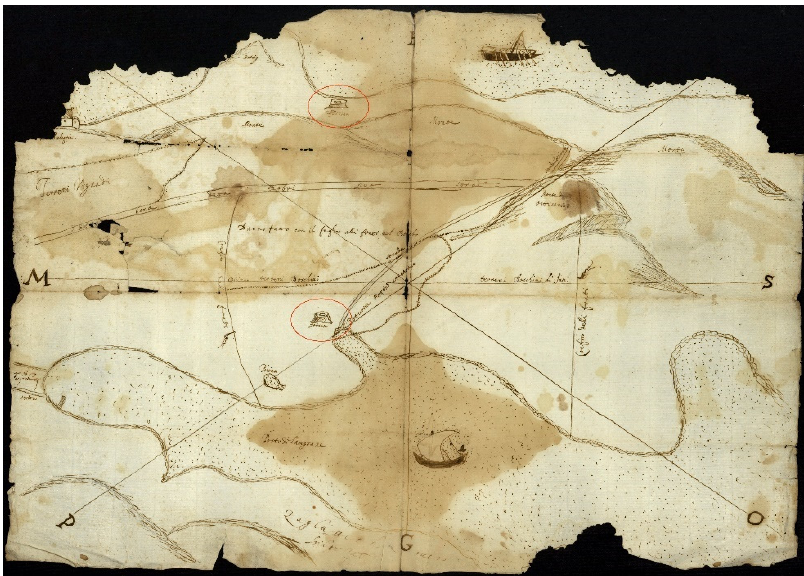
Figure 7. Drawing of a lime kiln as truncated cones with an opening in the middle of the roof (red ellipses) in a cadastral-topographic sketch of Kali (Ugljan Island), 1736.